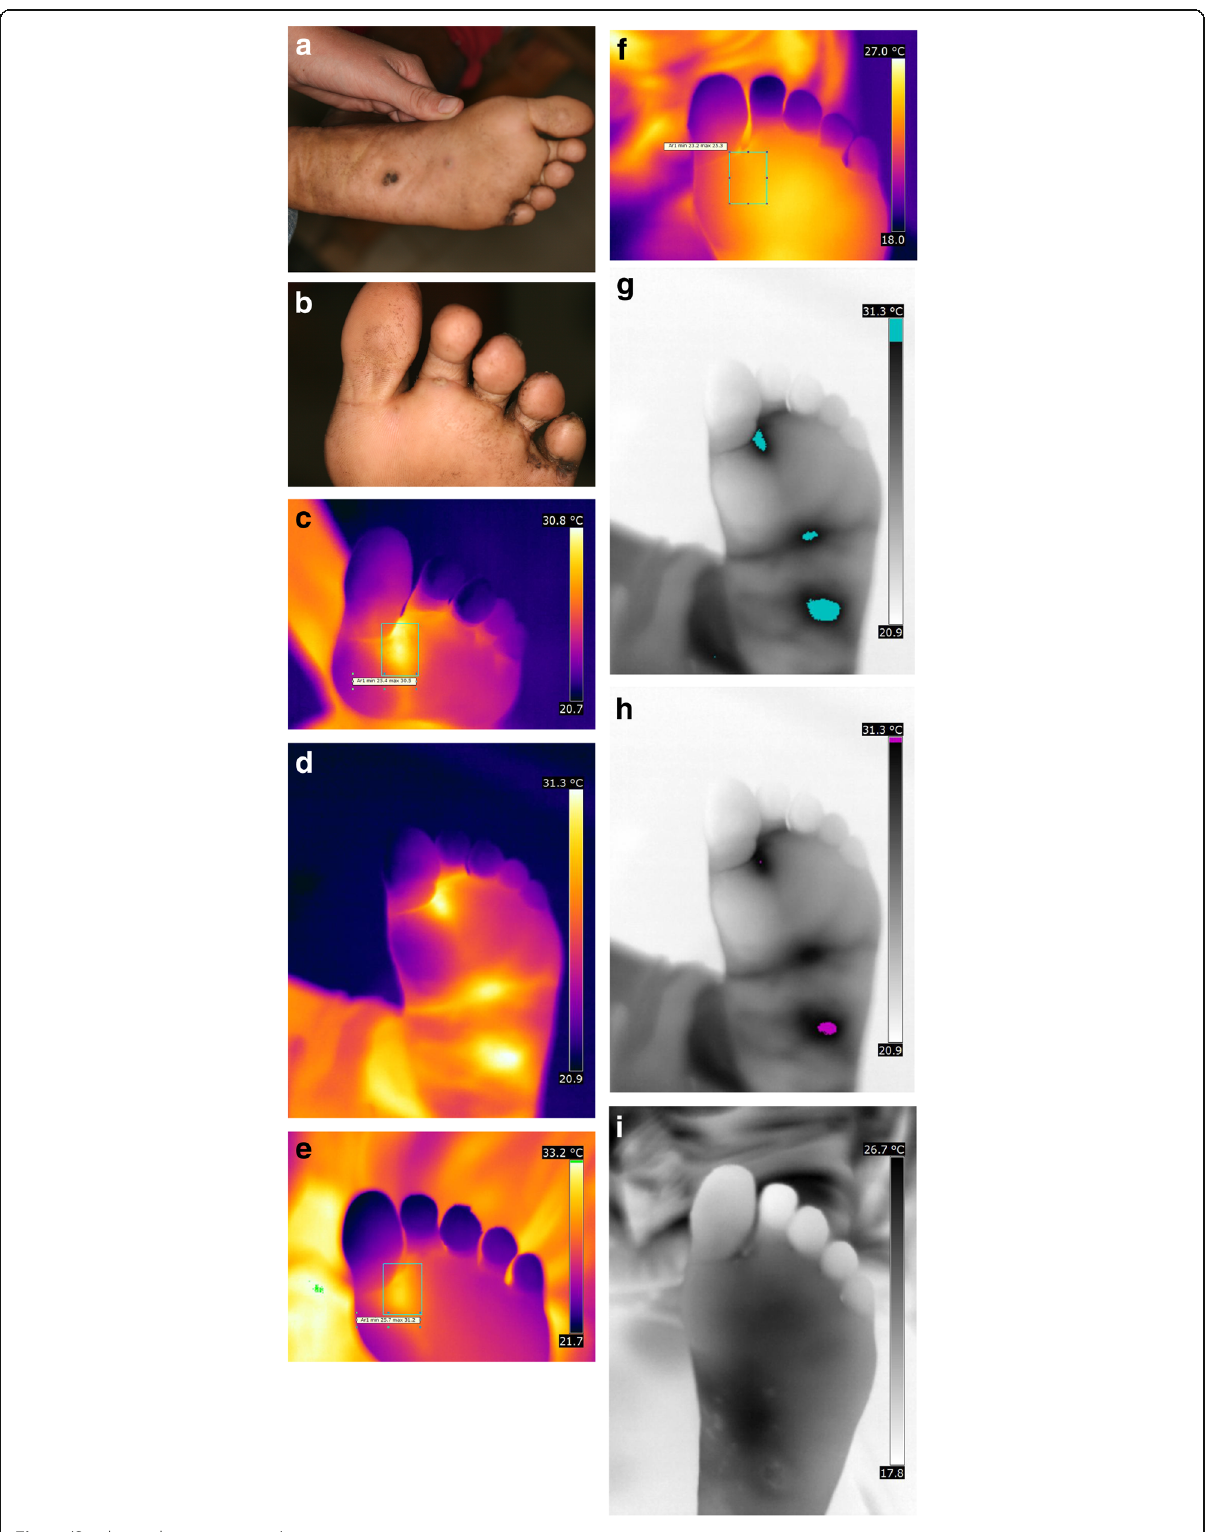
Fig. 7 (See legend on next